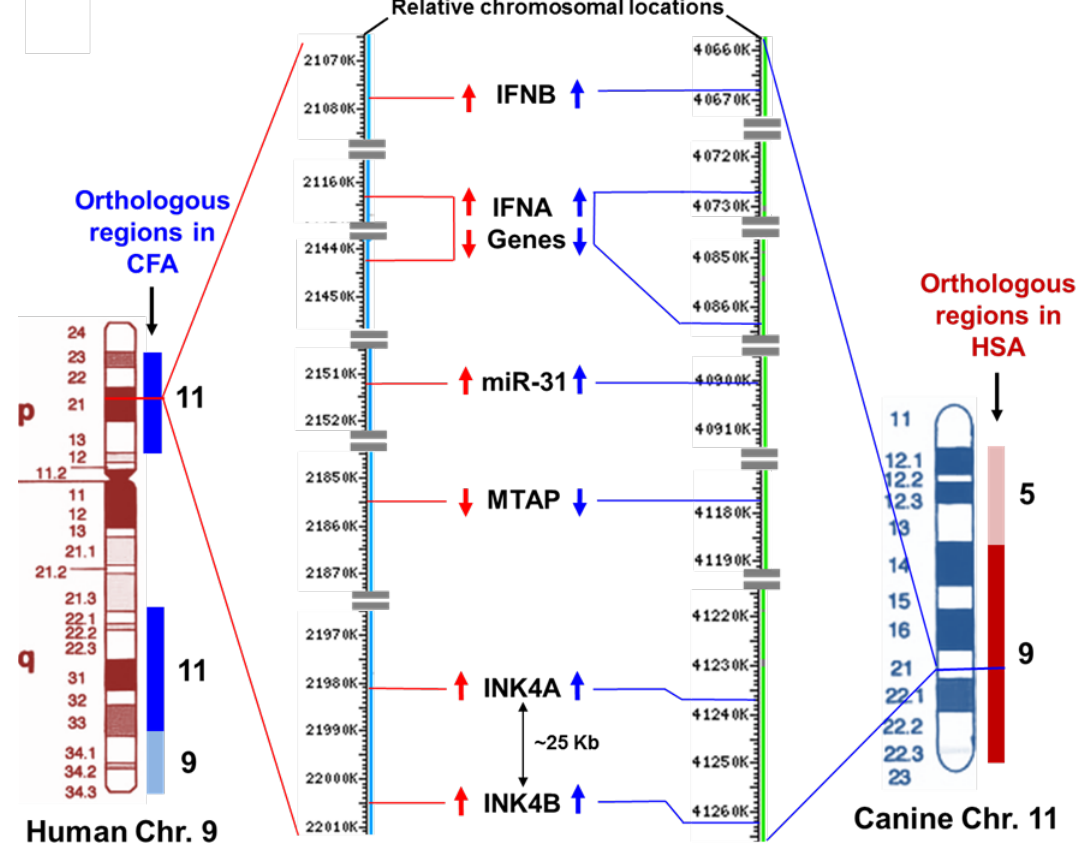
Figure 4. Relative molecular and cytogenetic mapping of the INKA/ARF locus and closely related genes with their positions on human and canine chromosome 9 and 11, respectively. The regions at human chromosome 9 and canine chromosome 11 that are frequently deleted in cancers are completely orthologous to each other. The molecular mapping shows the exact chromosomal position of these genes extrapolated from the NCBI map view of each chromosome represented by the current human and canine annotation from releases 106 and 103, respectively. The red and blue arrows indicate the transcriptional orientation of genes in the human and dog chromosomes, respectively. Transcription of genes from the “+ strand” is indicated by down arrows and from the “– strand” by up arrows. (CFA = Canis lupus familiaris; HSA = Homo sapiens; Chr. =